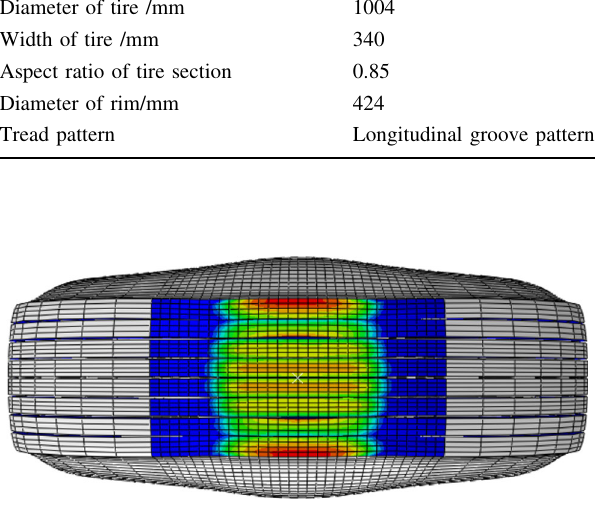
Fig. 2 Contact mark of walking wheel under the action of 5500 kg static